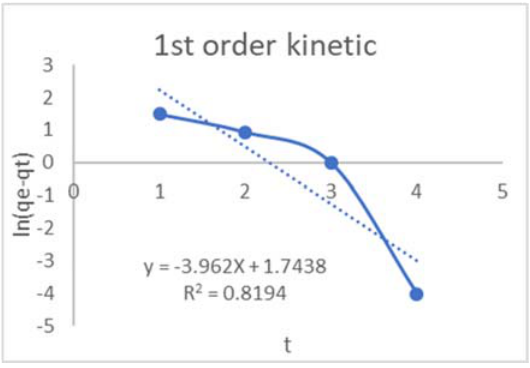
Fig. 11 Pseudo first order plot of IC Adsorption by corn leaves.